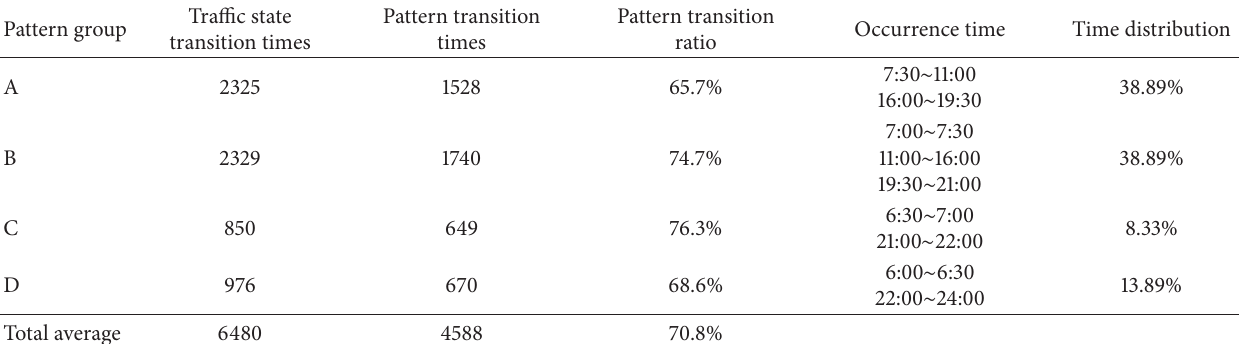
Table 1: A detailed table of the transition characteristics of pattern